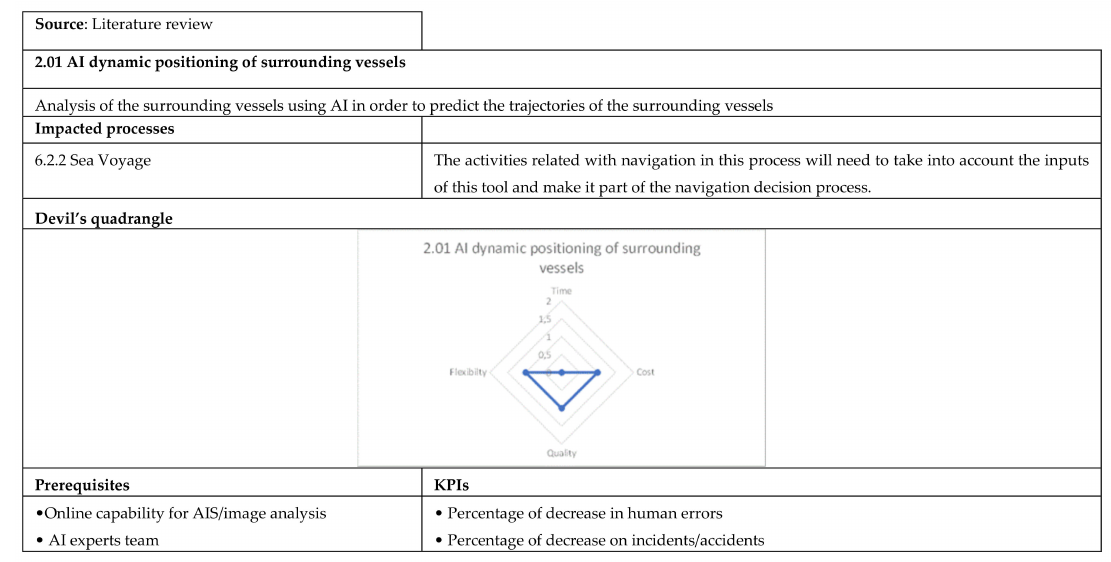
Figure A5. AI dynamic positioning of surrounding vessels data sheet.